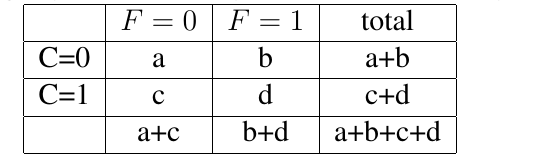
Table 1: The contingency table of a binary feature F w.r.t. a binary class variable C . F = 0 F = 1